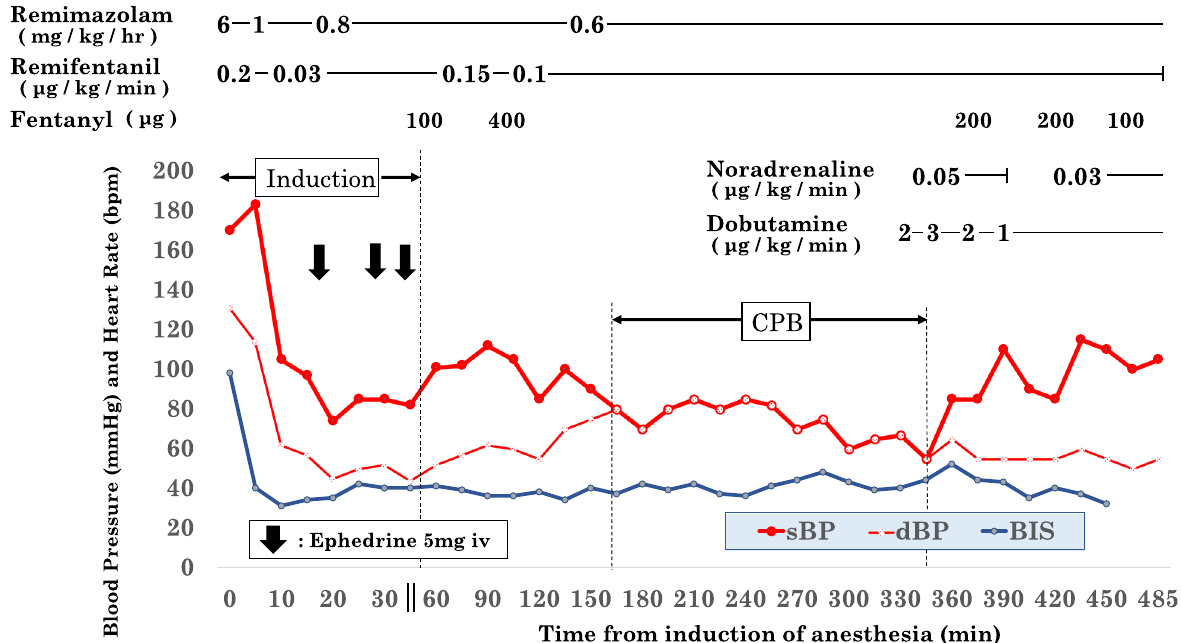
Fig. 1 Anesthetic record. sBP, systolic blood pressure; dBP, diastolic blood pressure; BIS, bispectal